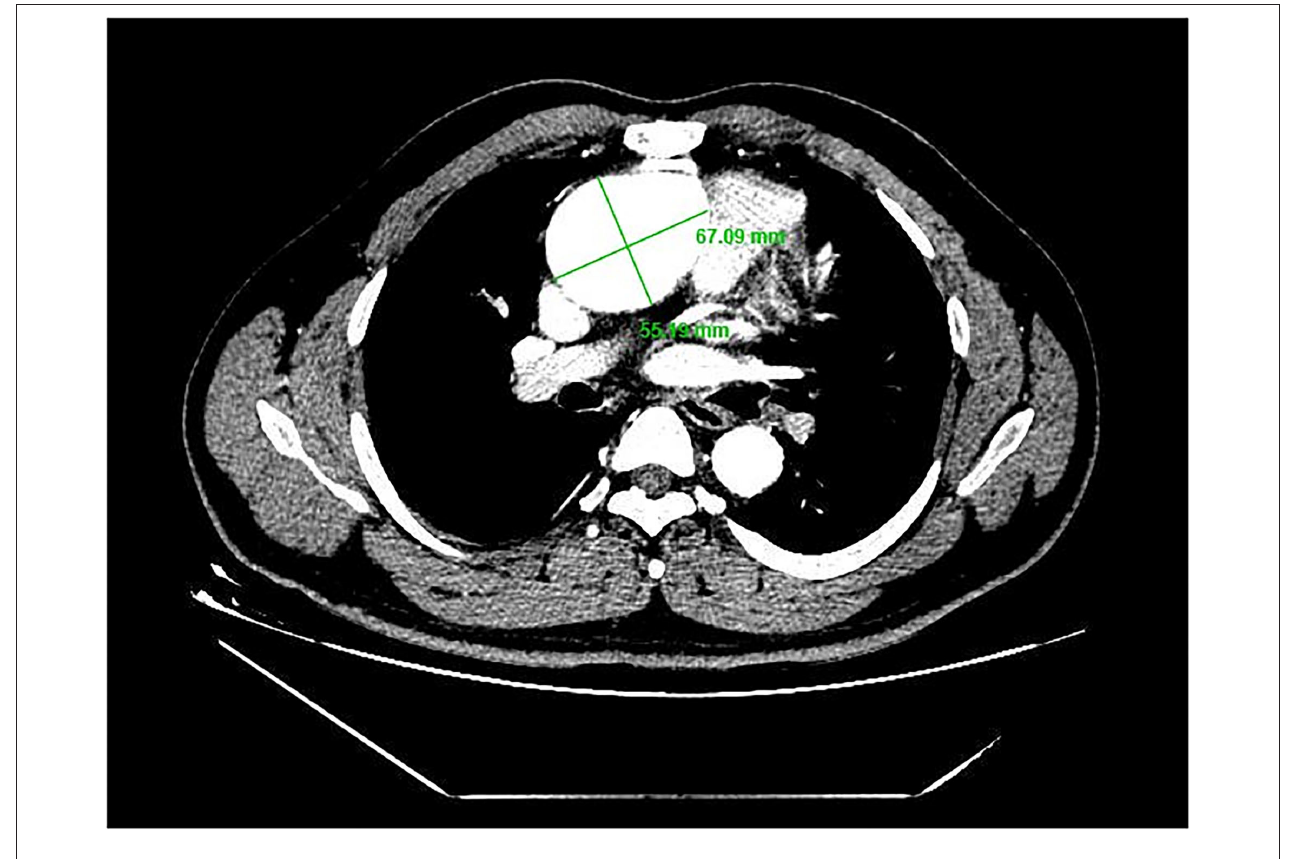
FIGURE 2 | Diameter of aortic root 55.19mm × 67.09mm.